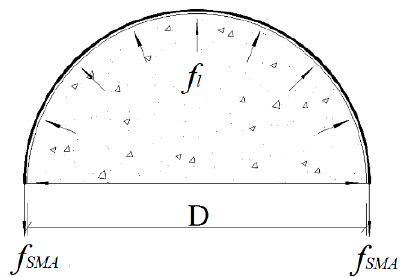
Figure 11. Superelastic SMA wire reinforced concrete cylinder.